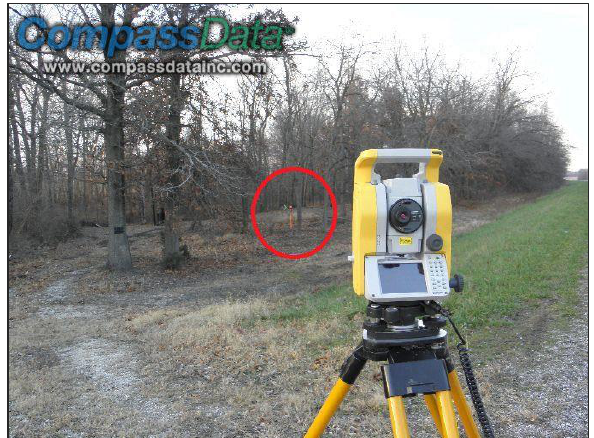
Figure 8. Total station and surveyed test point under vegetation in red circle